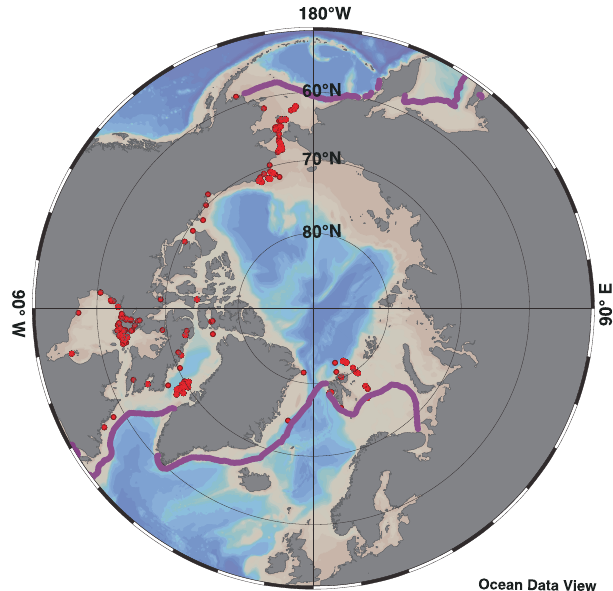
Fig.1|Samplecollectionmap. Locationswhereanimalsweresampledthroughout themarginalseasoftheArcticregion,spanningJanuarytoDecemberbetween1982 and 2019. Magenta line represents the median March sea-ice extent (1981 – 2010). Map created with Ocean Data View 104